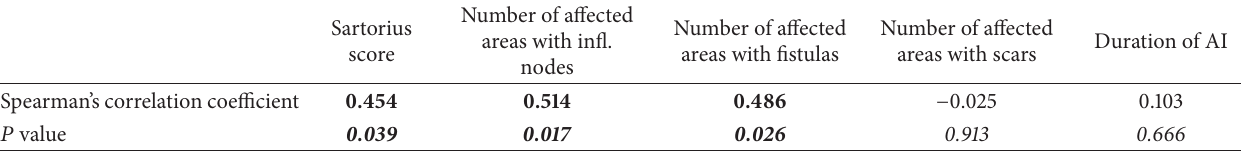
Table 1: MMP8 blood levels positively correlate with AI activity.